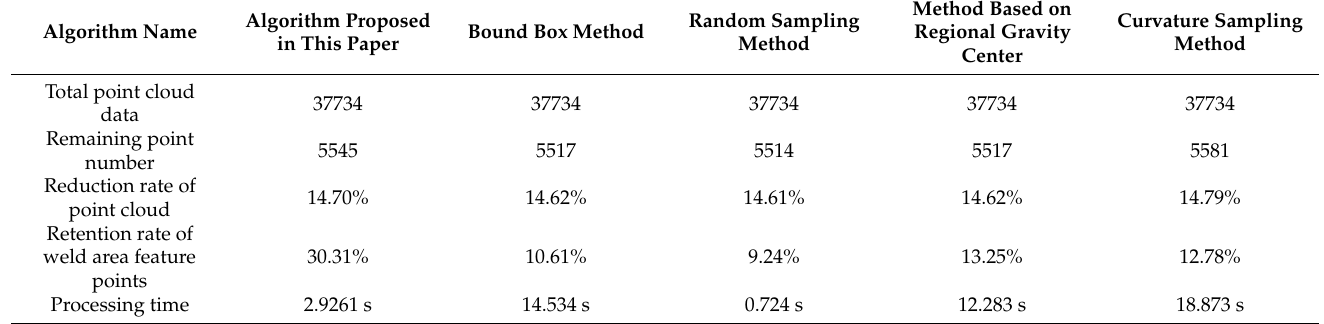
Table 2. Comparison results for five simplification methods of point cloud data of T-profile plate.